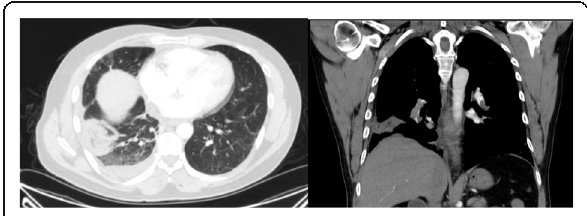
Fig. 9 Pulmonary embolism: thin section CT in axial plane in lung window shows subpleural consolidation with reverse halo sign(RHS), coronal image in mediastinal window show filling defect in lower lobes pulmonary arteries suggestive for pulmonary